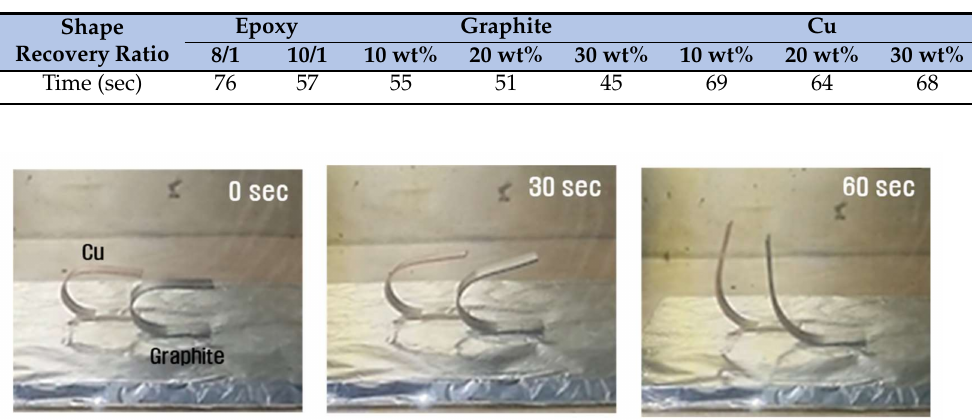
Table 6. Time when the shape recovery rate is 50%.